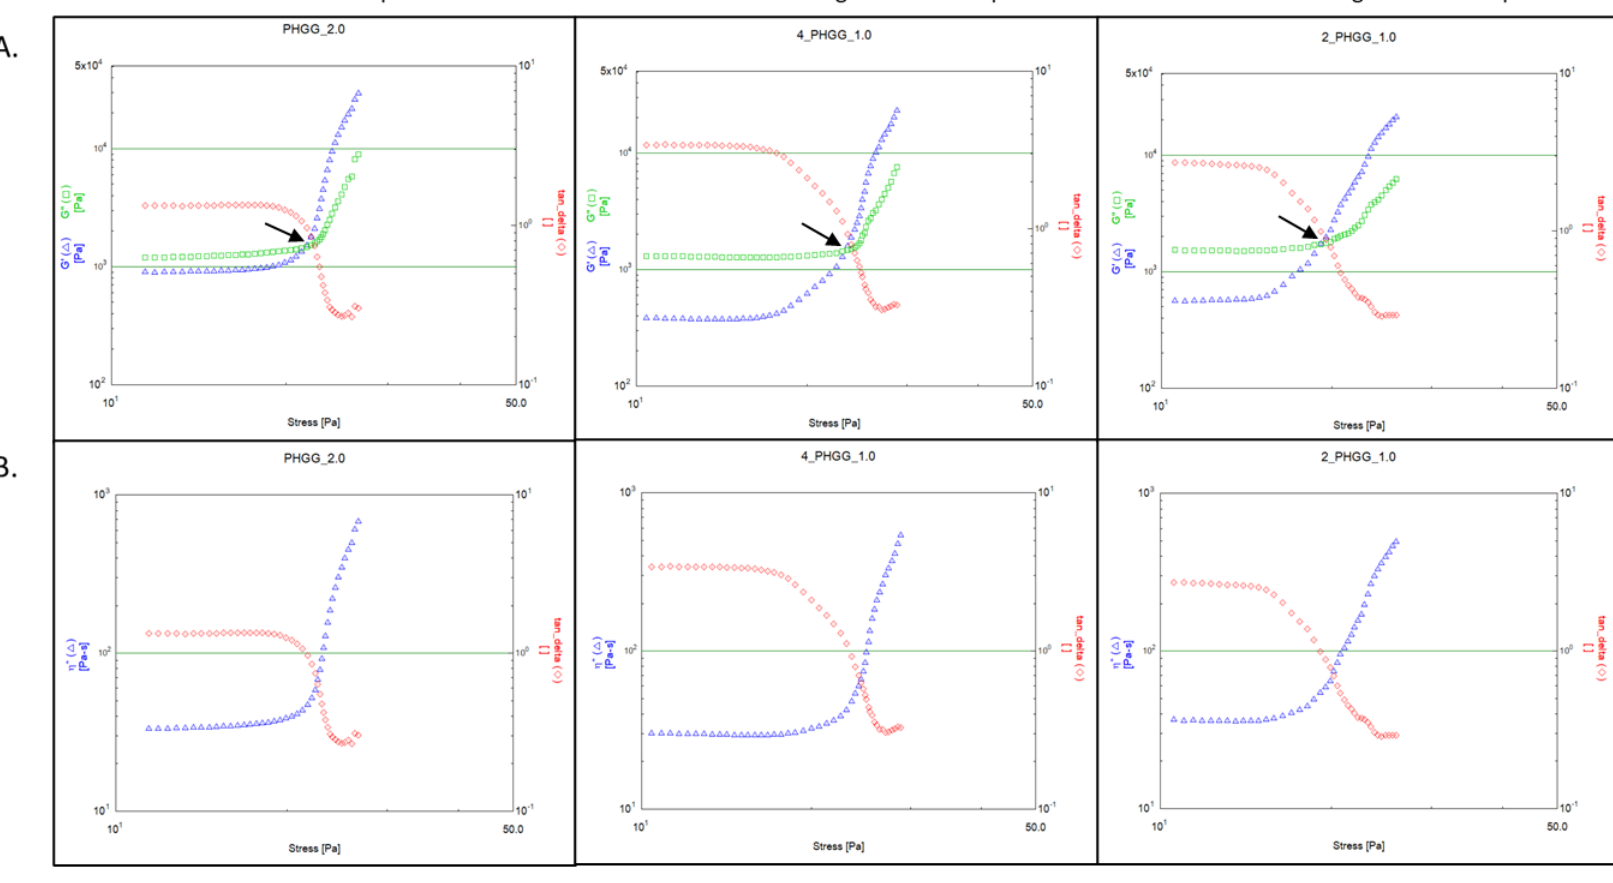
Figure 3. An example of dilatant rheological behaviour observed in partially hydrolysed guar gum (PHGG). Graphs show ( A ) rheological yield points (top half, y-axis left: G’ and G” in Pa, y-axis right: Tan ( δ ), x-axis bottom: shear stress in Pa) and ( B ) complex viscosity (bottom half, y-axis left: η * in Pa.s, y-axis right: tan ( δ ), x-axis bottom: shear stress in Pa) plots as shear stress is gradually increased in distilled water (pH 7), simulated digestions with SDF-PPI (simulated digestion fluid proton pump inhibitor at pH 4) and SDF (simulated digestion fluid at pH 2). The black arrow in each plot indicates the yield point where Tan ( δ ) = 1. Note that the rheological behaviour does not change under chemically simulated digestion.